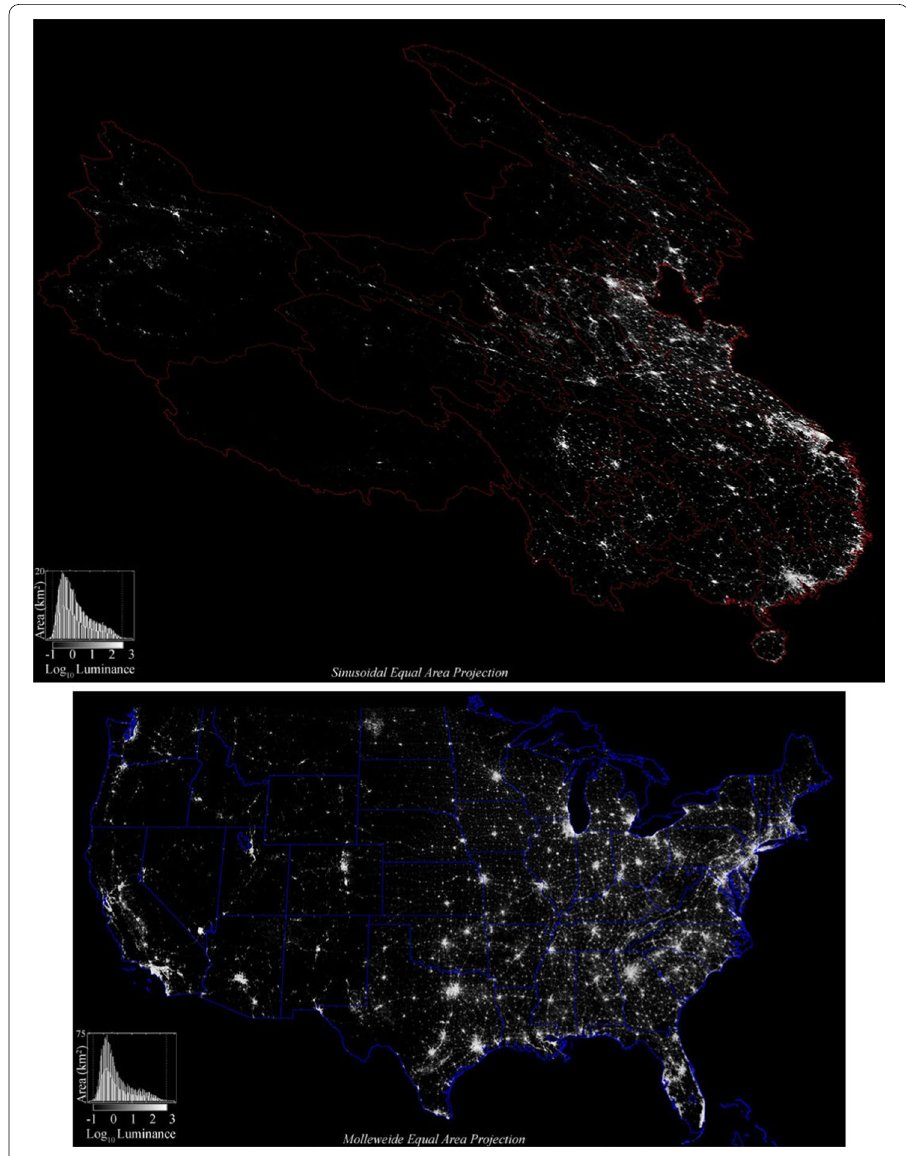
Fig. 1 China and conterminous USA night light luminance as imaged by VIIRS in 2015. Because smaller isolated light sources are dimmer, the majority of lights cannot be seen at the scale of this figure. However, network structure is